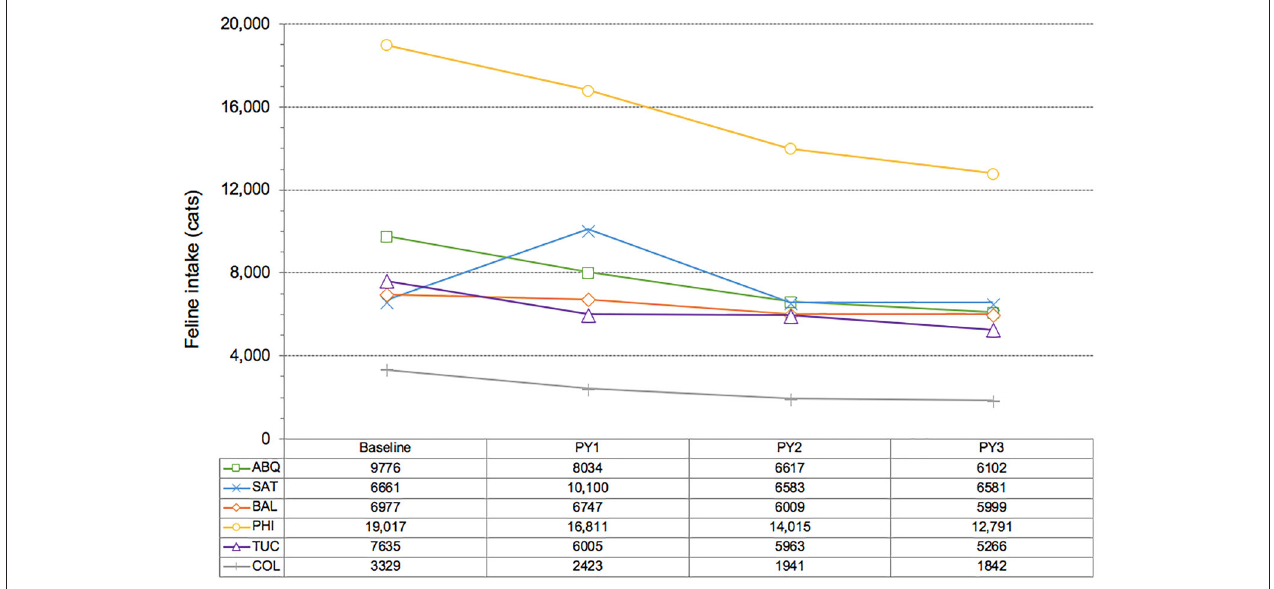
FIGURE 4 | Changes in feline intake at six CCP shelters, comparison of baseline level to intake during each of three program years (PY).